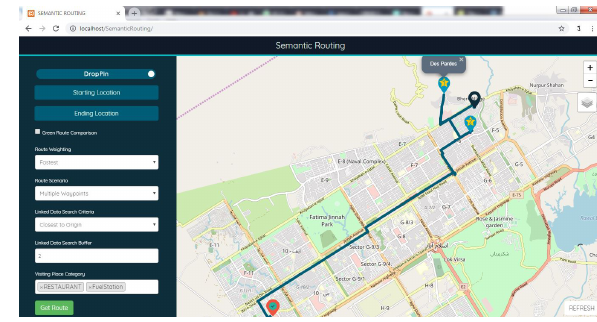
Figure 12. Routing through multiple waypoints, with first being closest to route origin